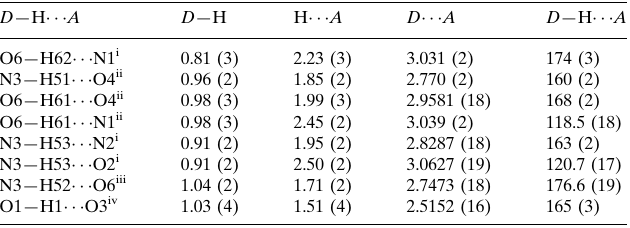
Hydrogen-bond geometry (A˚ , (cid:3)